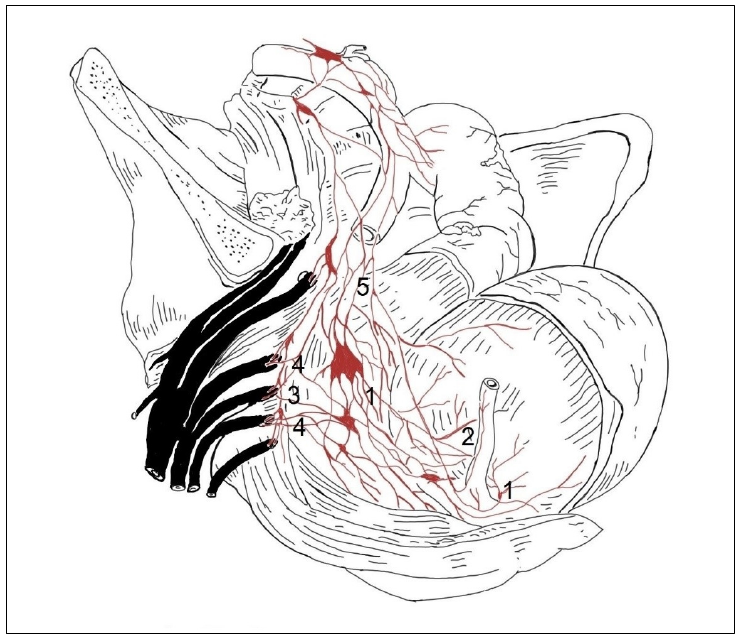
Figure 3. In the concentric type of sympathetic trunk, the plexuses of the rectum (1) and the urinary bladder (2) consist of a small number of large nerve ganglia, and the connections with the sympathetic trunk (3) are more weakly expressed. Nn. erigentes pelvici (4) were rare. The plexus hypogastricus inferior (5) was formed by a small number of branches, and the connections between them were less numerous.